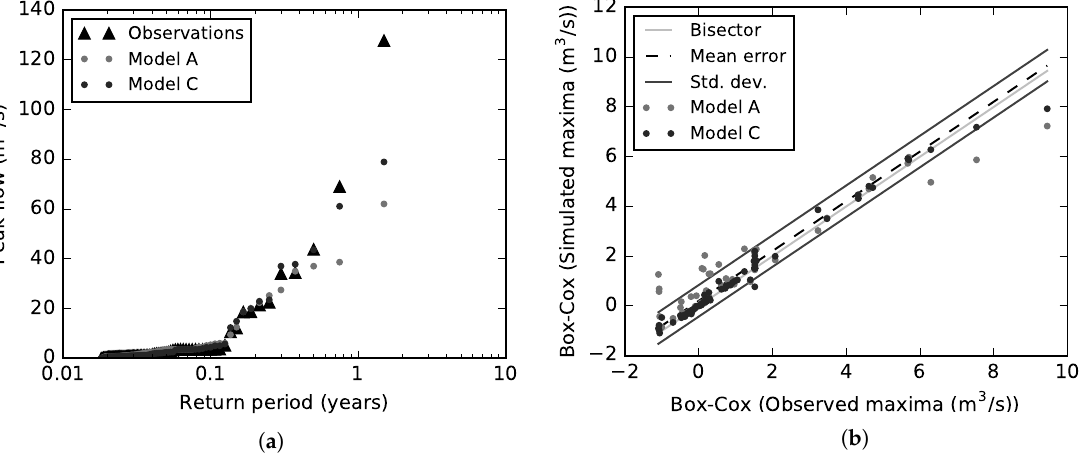
Figure 8. ( a ) Empirical extreme value distribution of peak flows; ( b ) Comparison of nearly independent peak flow maxima.